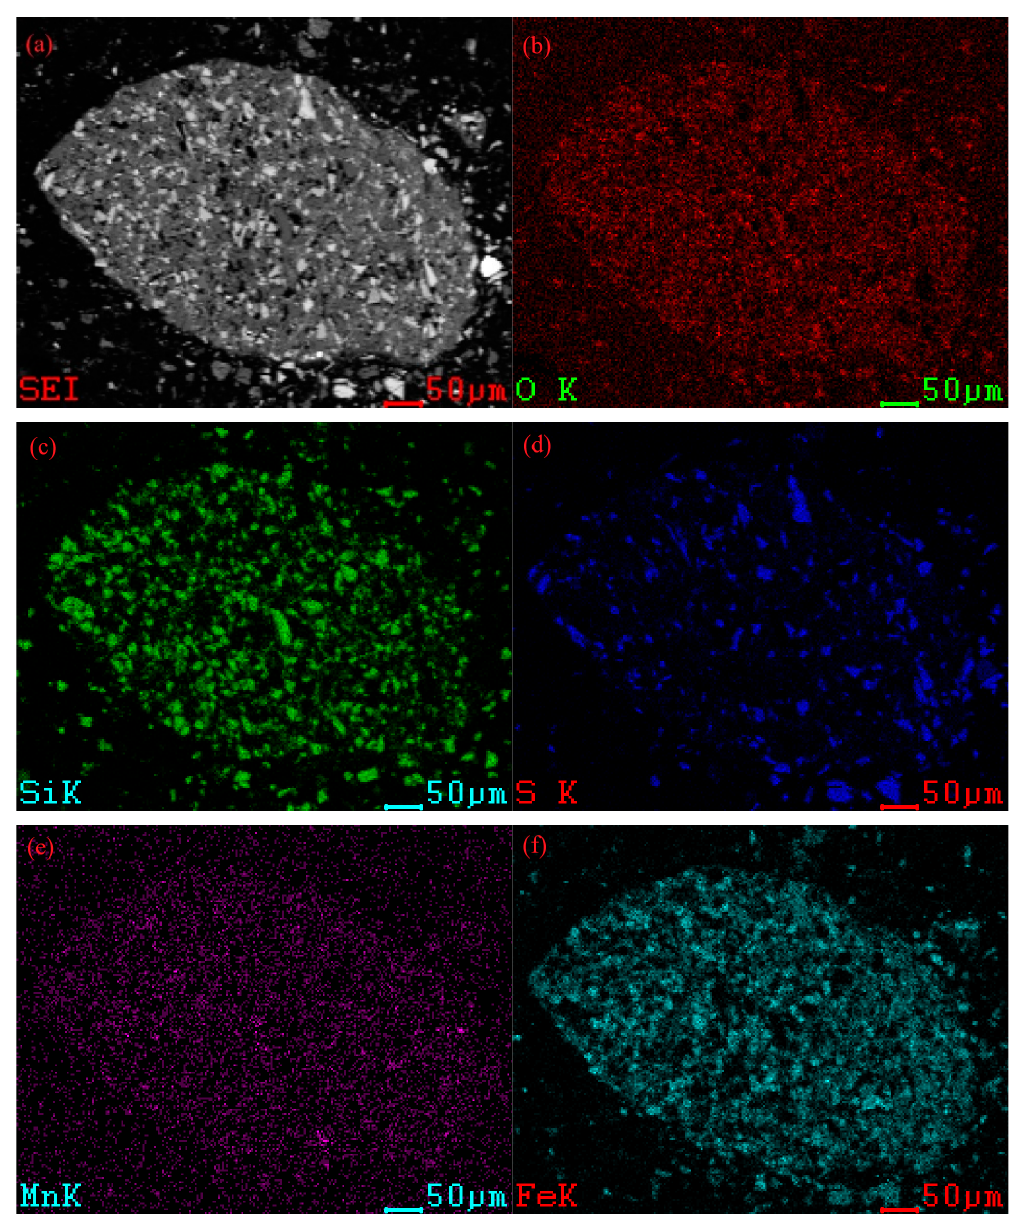
Figure 10. SEM micrographs with EDS layered map for two-stage leaching residual ( a – f ).